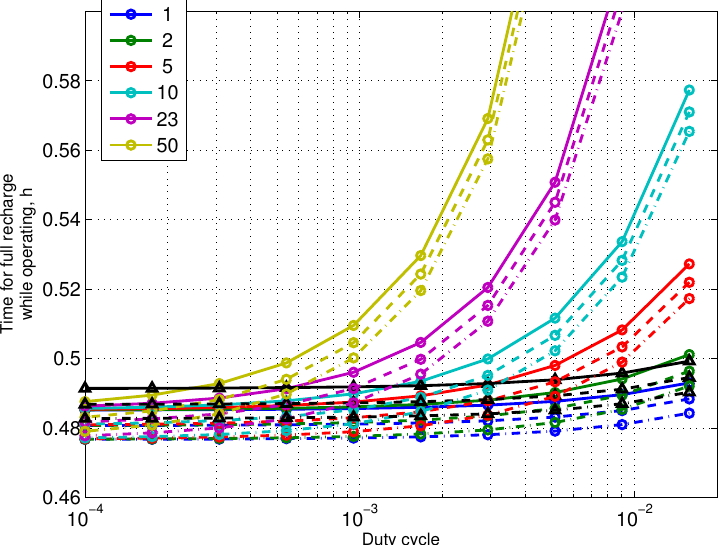
Figure 18. Detailed figure when M t = 1 and M r = 2, time for full recharge while operating with capacitor ( C s = 0.35 F). Non-WuR in black (without triangles), passive WuR in colors indicating number of nodes for different host duty cycles per node ( β (cid:48) w ). Semi-passive WuR in black with triangles. Line type indicates used SC leakage current model as —: upper , - - -: median, and -.-.-: lower.